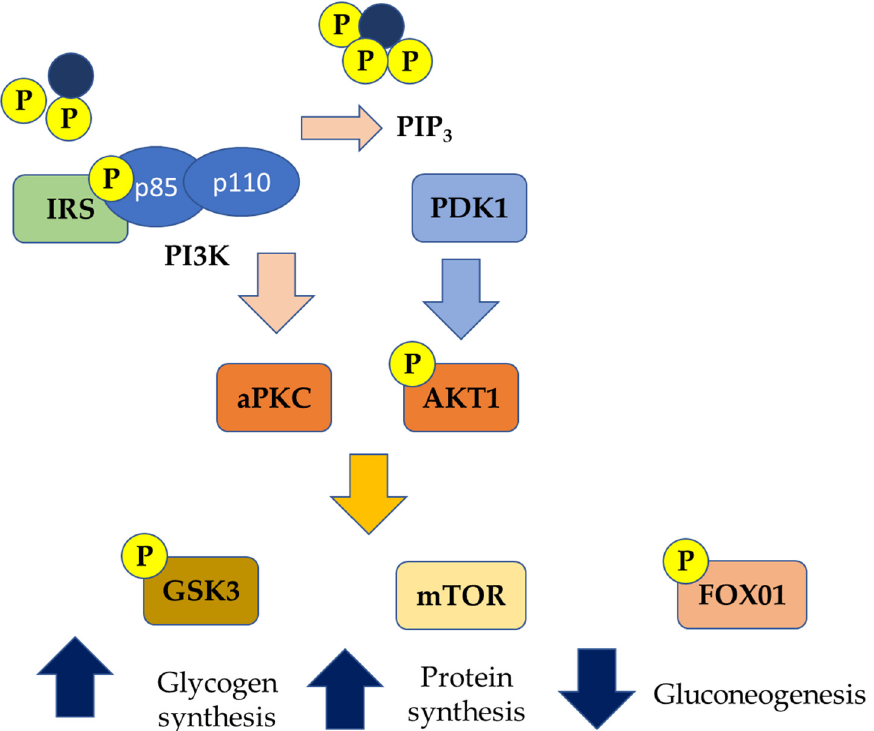
Figure 2. Genetic pathways of insulin resistance (PIP3: Phosphatidylinositol (3,4,5)-trisphosphate; aPKC: Activated protein kinase C; AKT1: Protein kinase B; GSK3: Glycogen synthase kinase 3; mTOR: mammalian target of rapamycin; FOXO1: Forkhead box protein O1; PDK1: 3-Phosphoinositide-dependent protein kinase 1; P: phosphorylated).